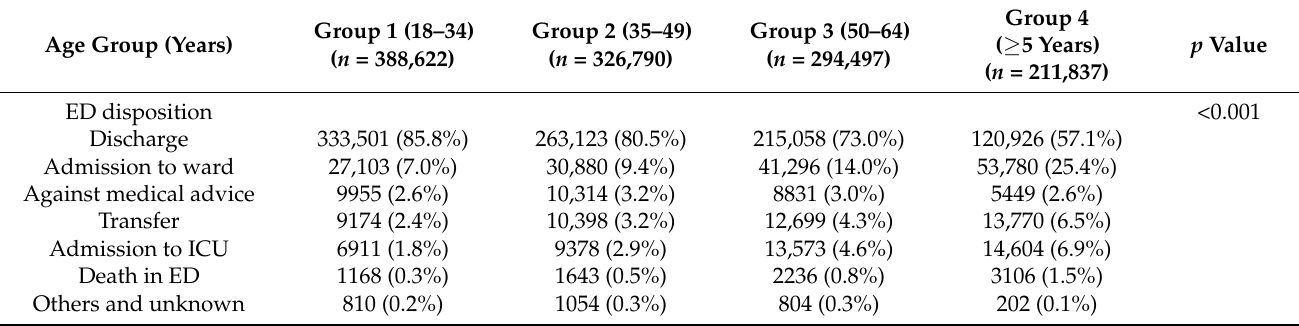
Table 4. Clinical outcomes of injury patients in the emergency room by age